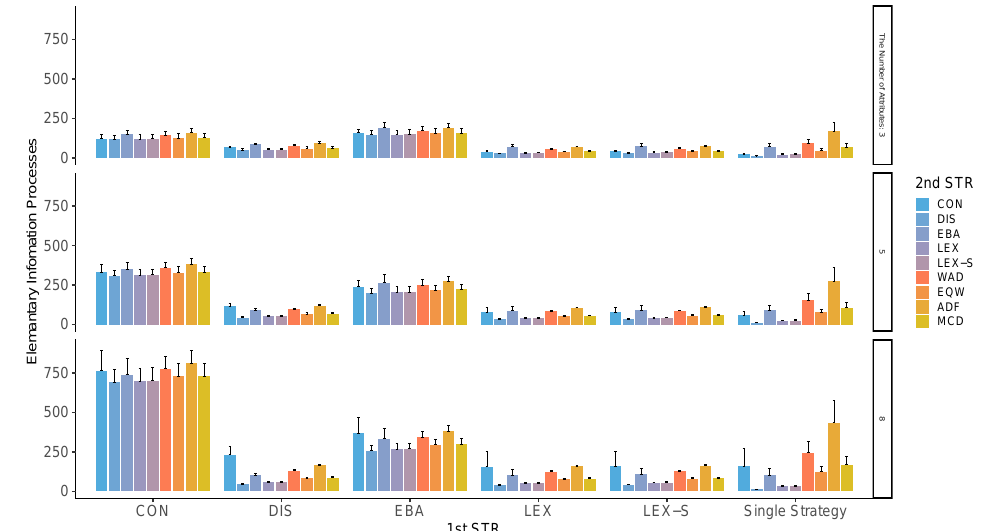
Figure A20. Average EIPs in two-stage decision-making when alternatives left in the second stage is three for the different numbers of attributes. Note: ADF: additive difference; CON: conjunctive; DIS: disjunctive; EBA: elimination by aspects; EQW: equal-weighted strategy; LEX: lexicographic; LEX-S: lexicographic semi-order; MCD: majority of confirming dimensions; STR: strategy; WAD: weighted